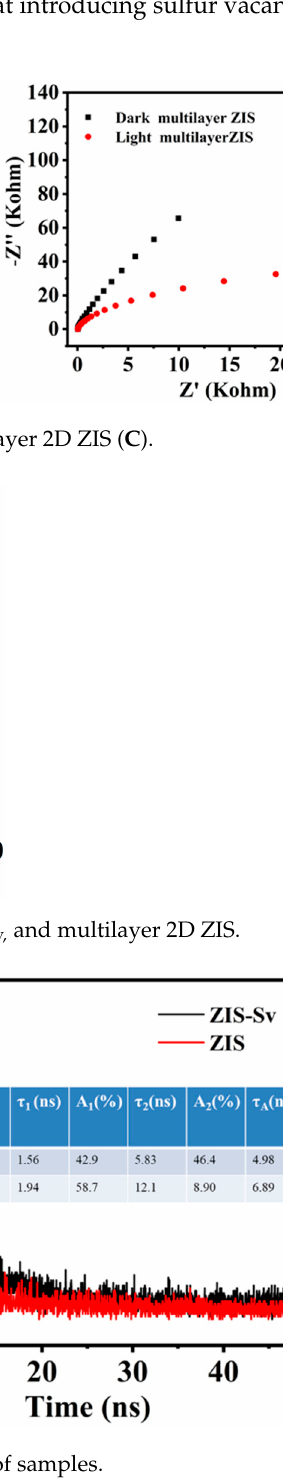
Figure 7. PL spectra ( A ) and TRPL decay spectra ( B ) of samples.